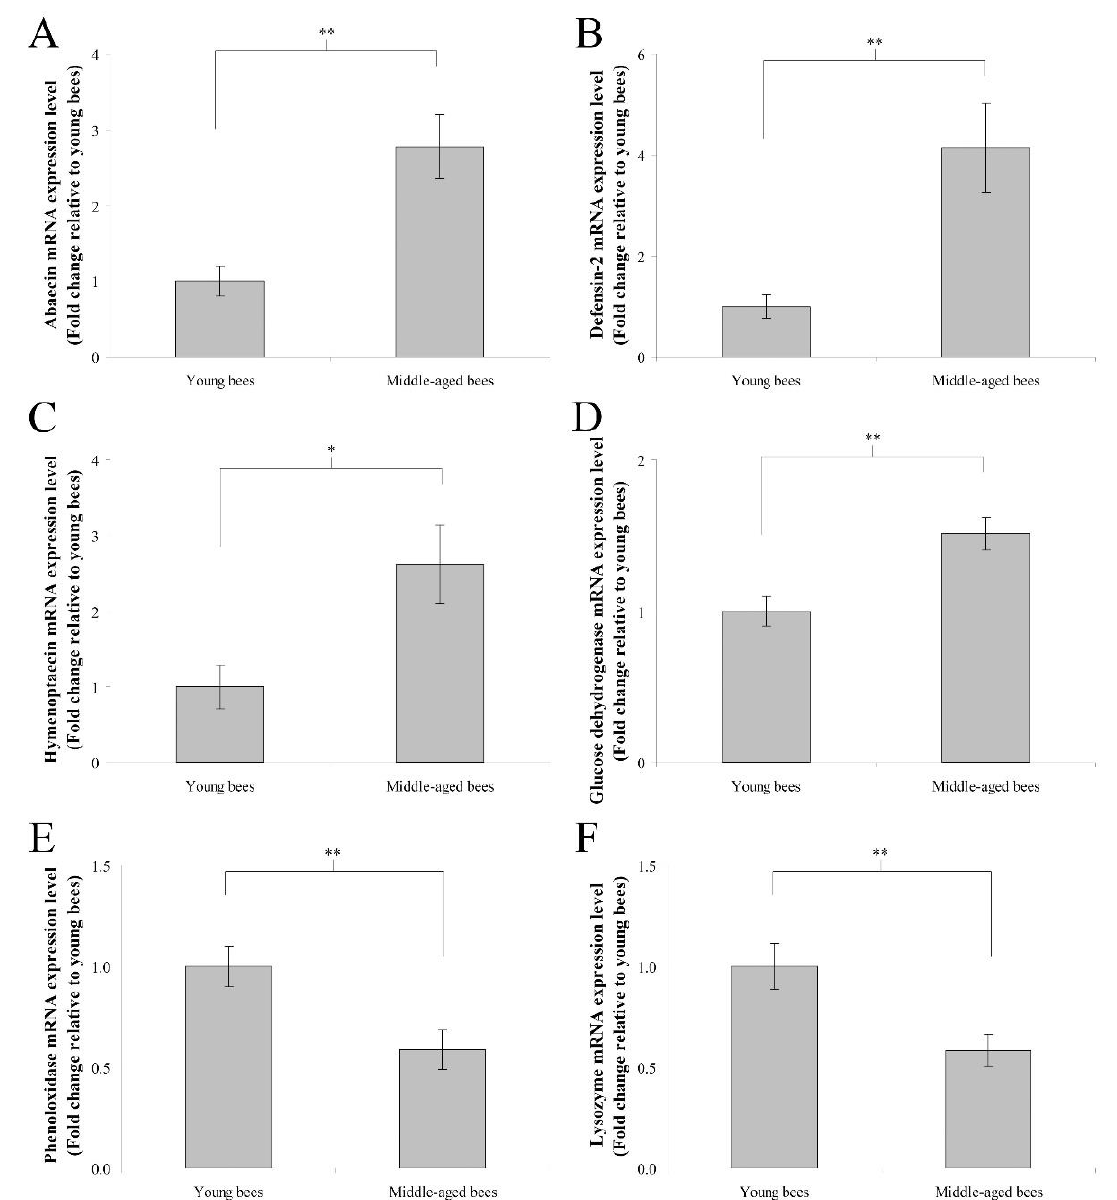
Figure 3. The genes expression of abaecin, defensin-2, hymenoptaecin, glucose dehydrogenase, phenoloxidase, and lysozyme from the abdomen without the digestive tract of young and middle-aged worker bees reared in an incubator. The mRNA expression levels of abaecin ( A ), defensin-2 ( B ), and hymenoptaecin ( C ), glucose dehydrogenase ( D ), phenoloxidase ( E ), and lysozyme ( F ) genes were normalized to young worker bees and shown as fold changes, representing the mean ± SEMs ( n = 10). The asterisks indicate significant differences (* p < 0.05, ** p < 0.01; two-sample t -test).